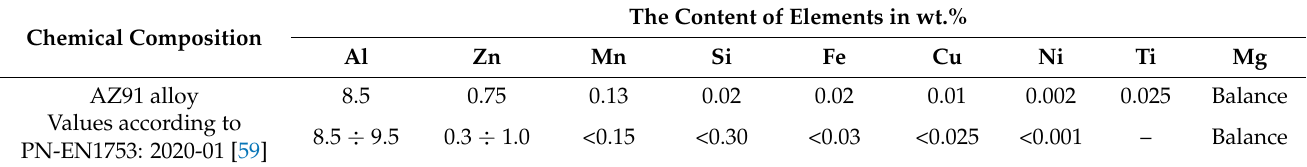
The Content of Elements in wt.%